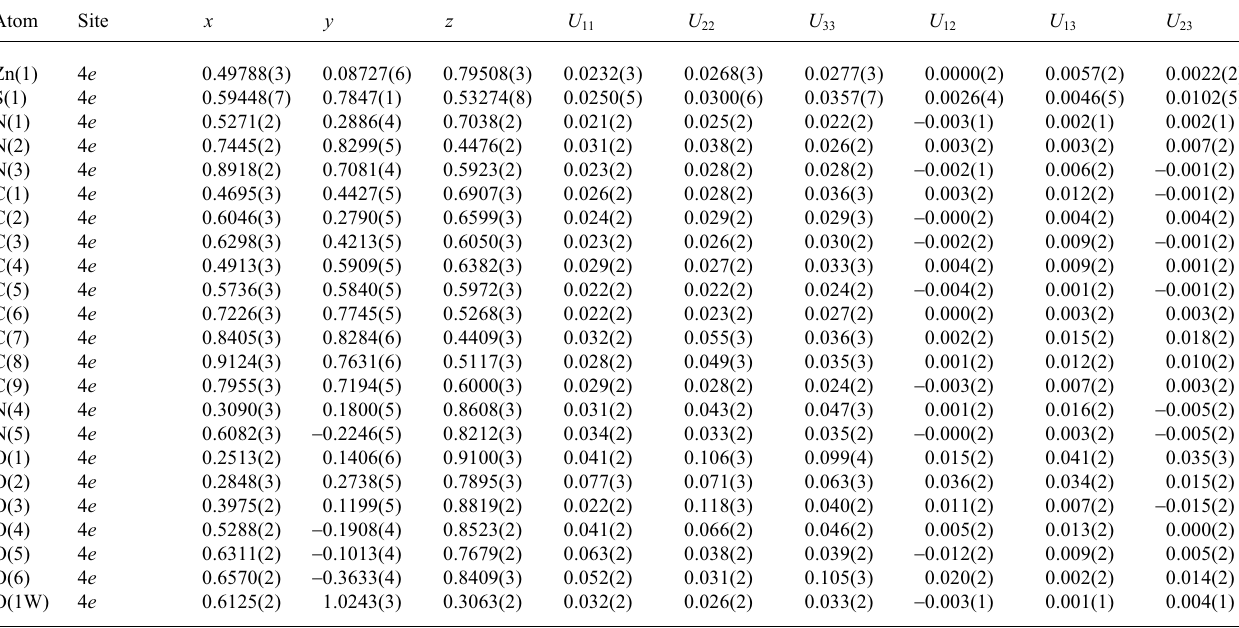
Table 3. Atomic coordinates and displacement parameters (in Å 2 )